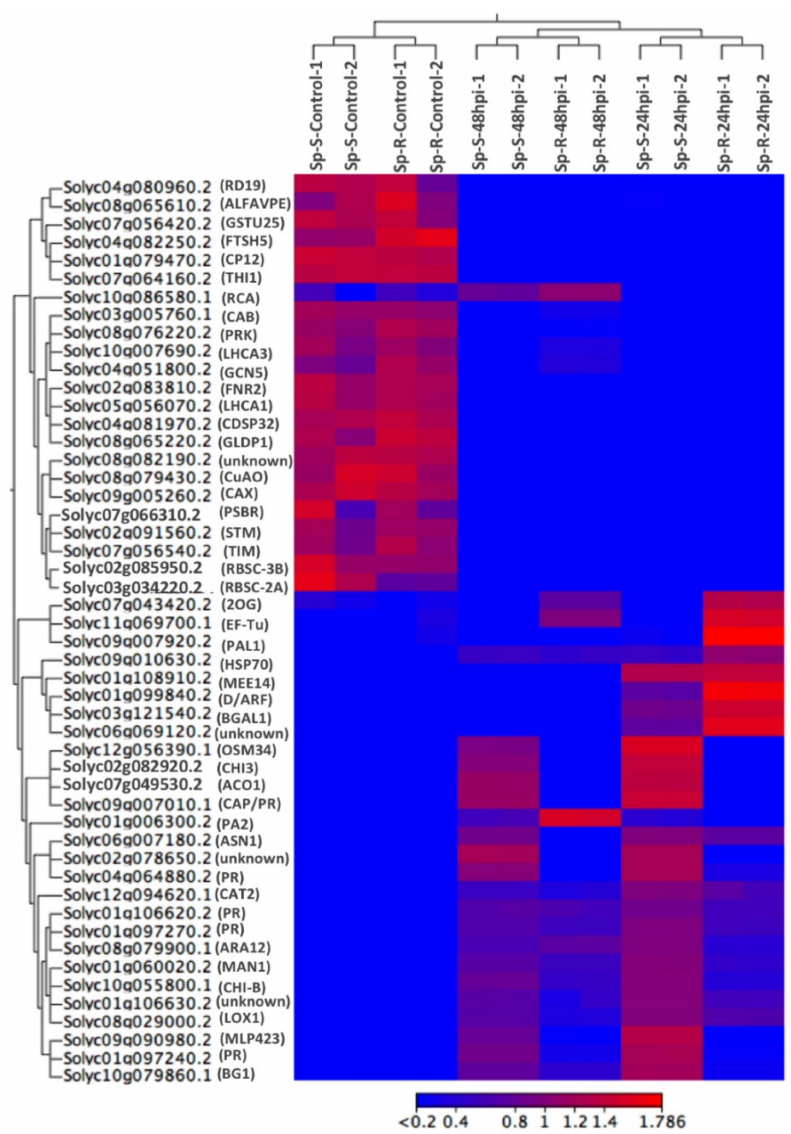
Figure 5. Heat map showing hierarchical cluster analysis of top 50 highly expressed genes across all samples. It shows that many core plant defense genes have differential expression profiles both among treatment vs. control as well as Sp-R vs. Sp-S conditions. Gradient scale is representing expression levels with red showing highest expression to blue with lowest